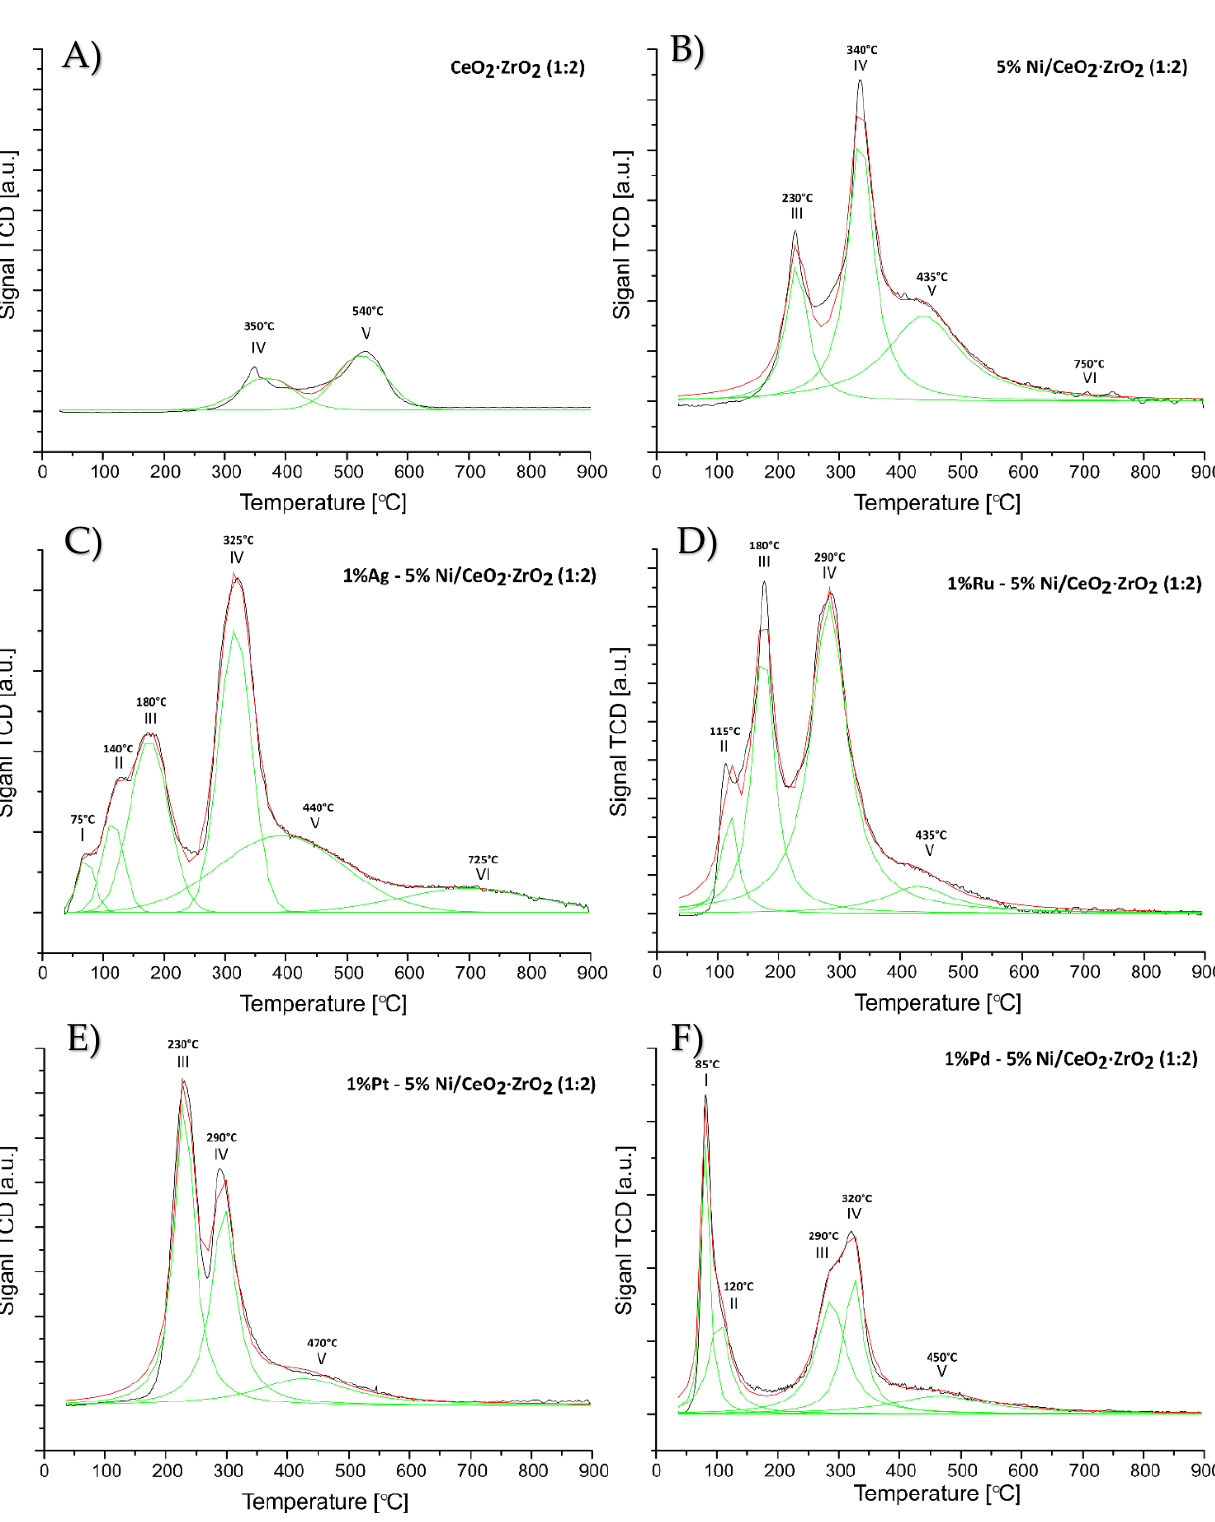
Figure 1. TPR-H 2 profiles for ( A ) support CeO 2 ·ZrO 2 (1:2), monometallic ( B ) 5%Ni/CeO 2 ·ZrO 2 (1:2) and bimetallic catalysts ( C ) 1%Ag-5%Ni/CeO 2 ·ZrO 2 (1:2) ( D ) 1%Ru-5%Ni/CeO 2 ·ZrO 2 (1:2) ( E ) 1%Pt-5%Ni/CeO 2 ·ZrO 2 (1:2) ( F ) 1%Pd- 5%Ni/CeO 2 ·ZrO 2 (1:2) calcined in an air atmosphere at 400 °C for 4 h .